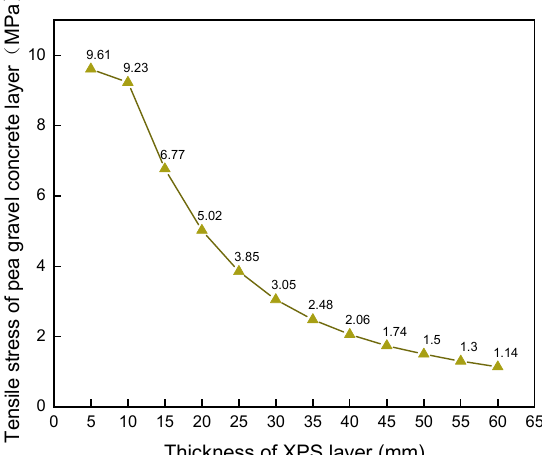
Figure 4. Relationship between XPS layer thickness and maximum tensile stress of pea gravel concrete layer.